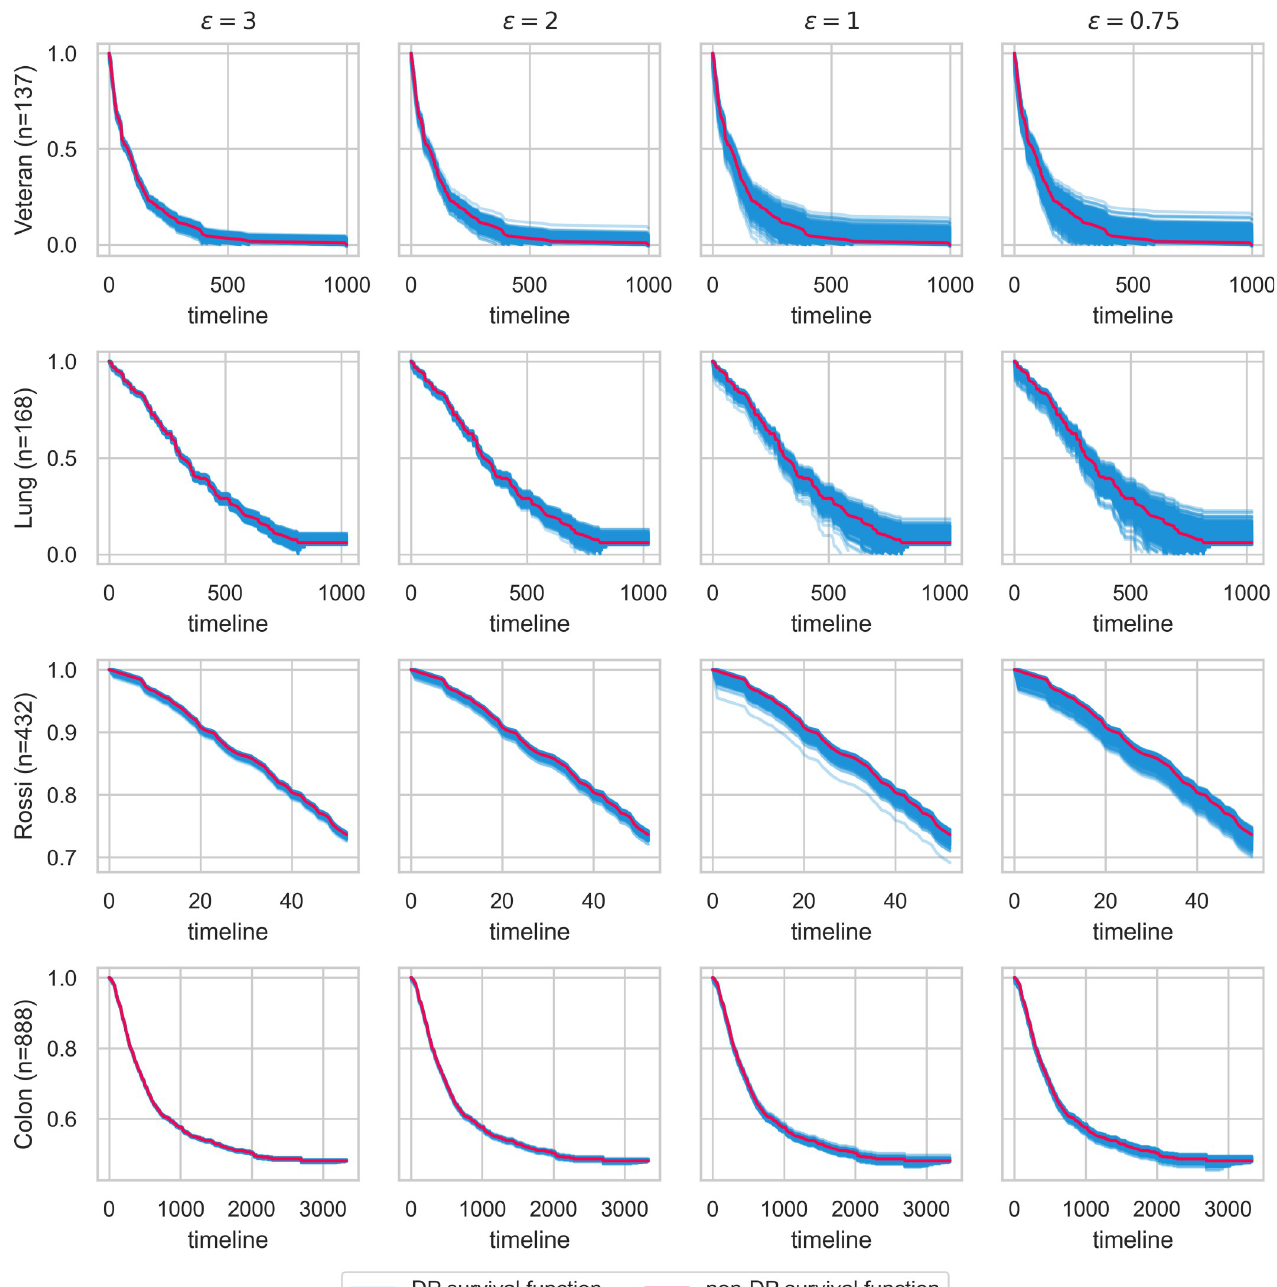
Fig 3. Comparison of DP survival functions against the non-DP baseline. The non-DP survival function (red) is used as a baseline against 1000 runs of DP survival functions for different epsilons and datasets. The resulting DP survival functions (blue) become noisier with decreasing epsilon. Note that the influence of the noise increases with decreasing sample